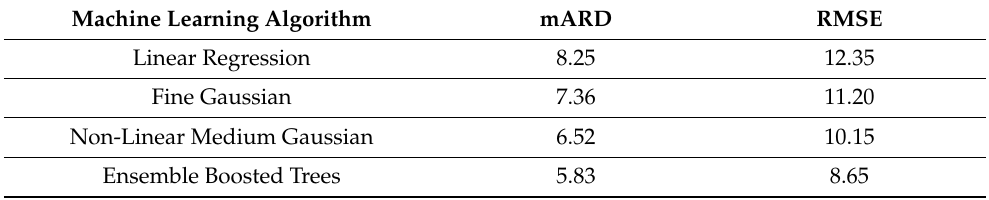
Table 2. Performance of different machine learning algorithms for the new feature set. Machine Learning